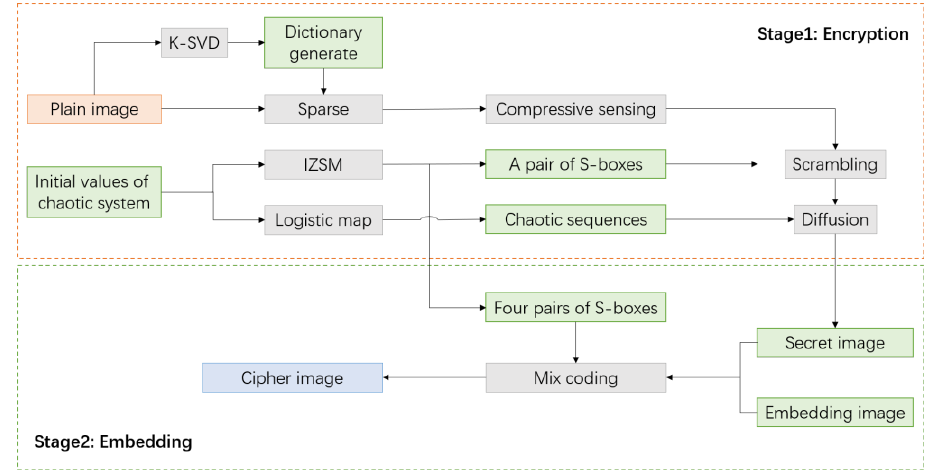
Figure 4. The scheme for image encryption.